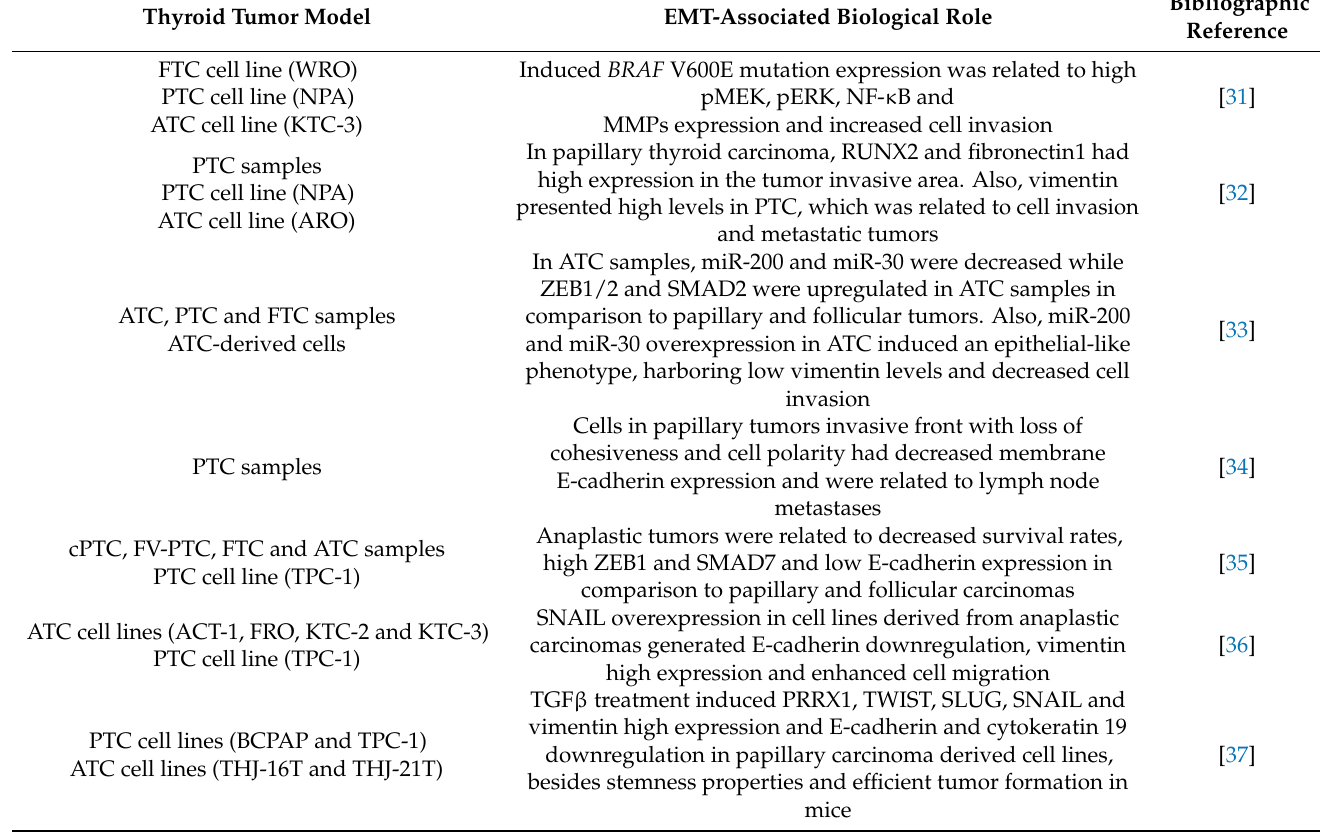
Table 1. EMT modulates diverse thyroid cancer progression